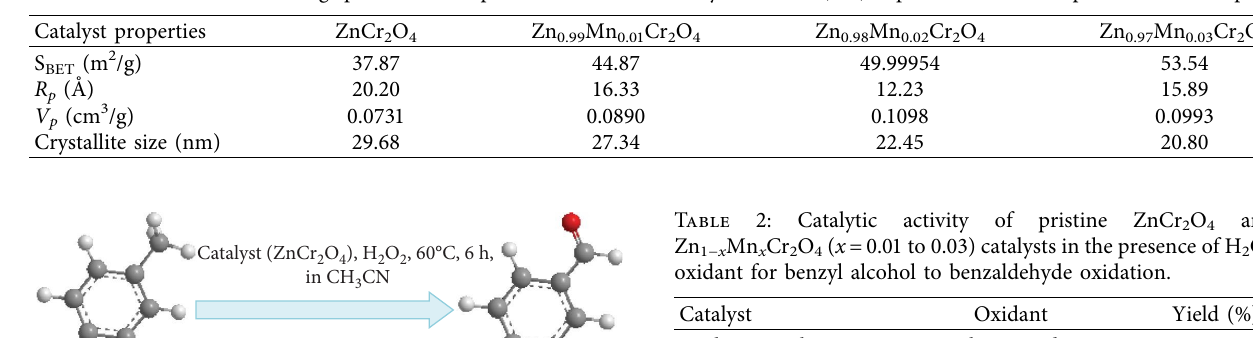
2 O 4 and (c, d) Zn 0.97 Mn 0.03 Cr 2 O 4 . 2 O 4 samples.